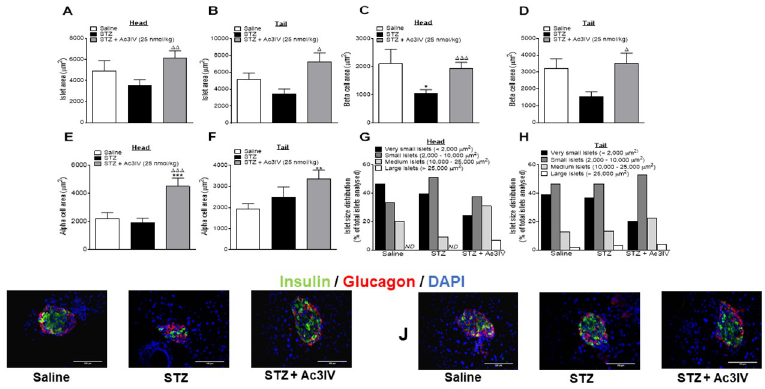
Fig 7. Effects of Ac3IV treatment on pancreatic morphology in STZ-diabetic GluCreERT2;Rosa26-eYFP mice. Parameters were assessed in the head (A,C,E,G) and tail (B,D,F,H) of the pancreas following 12 days twice-daily treatment with saline (0.9% NaCl) vehicle or Ac3IV (25 nmol/kg bw, i.p.) in STZ-diabetic GluCreERT2;Rosa26-eYFP transgenic mice. Islet (A,B), beta- (C,D) and alpha-cell (E,F) areas were assessed using CellF imaging software and the closed loop polygon tool. Islet size distributions in the head (G) and tail (H) of the pancreas are also shown. Representative images (40X) of stained islets are provided in panels I and J. Values are mean ± SEM for n = 6 mice. � p < 0.05, �� p < 0.01, ��� p < 0.001 compared to saline vehicle. Δ p < 0.05, ΔΔ p < 0.01 and ΔΔΔ p < 0.001 compared to STZ- diabetic controls. ND—not detected.